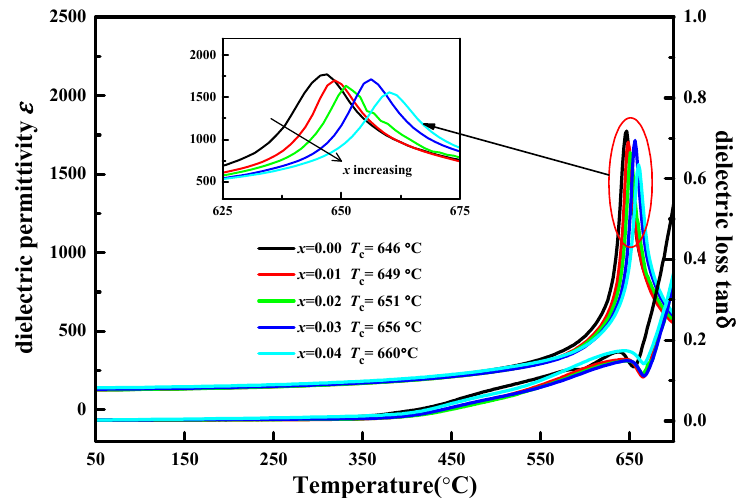
Figure 6. Temperature dependence of dielectric permittivity and dielectric loss tan δ at 1 MHz for the Mn/Nb co-doped NBT ceramics.